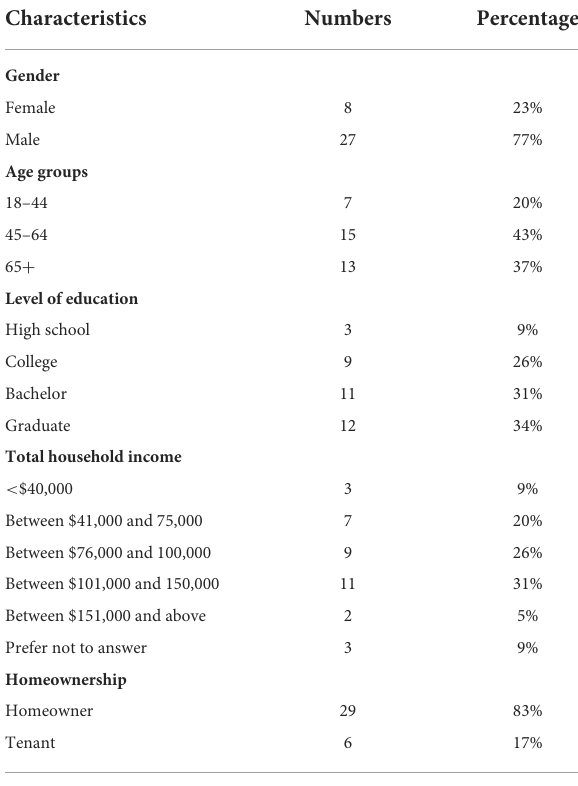
TABLE 2 Characteristics of qualitative study